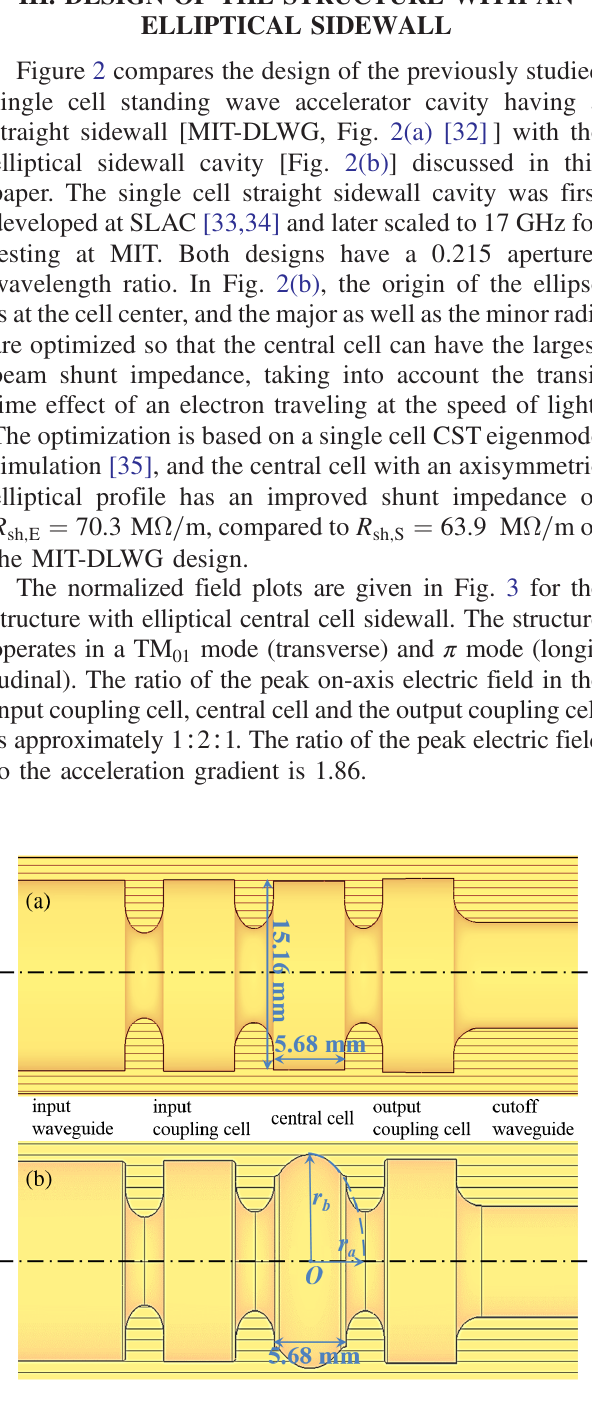
FIG. 2. Axisymmetric view of the 17 GHz single cell standing FIG. 4. Sample trajectories of the single surface multipactor wave disk-loaded waveguide structure with (a) straight (S) modes calculated with our particle tracking code. (a) N ¼ 1 mode and (b) elliptical (E) central cell sidewall profile (major radius at the gradient of 14 MV = m, (b) N ¼ 0 . 5 mode at 150 MV = m. r z ¼ 0 marks the cell ¼ 8 . 16 mm, minor radius r ¼ 4 . 30 mm). b a